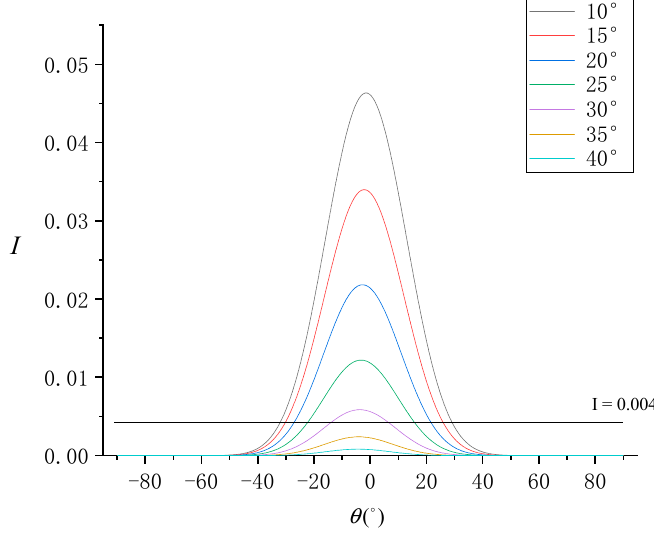
Figure 12. Normalized SG radiance ( I ) simulated under each SVA ( θ ) at di ff erent sun zenith angles.